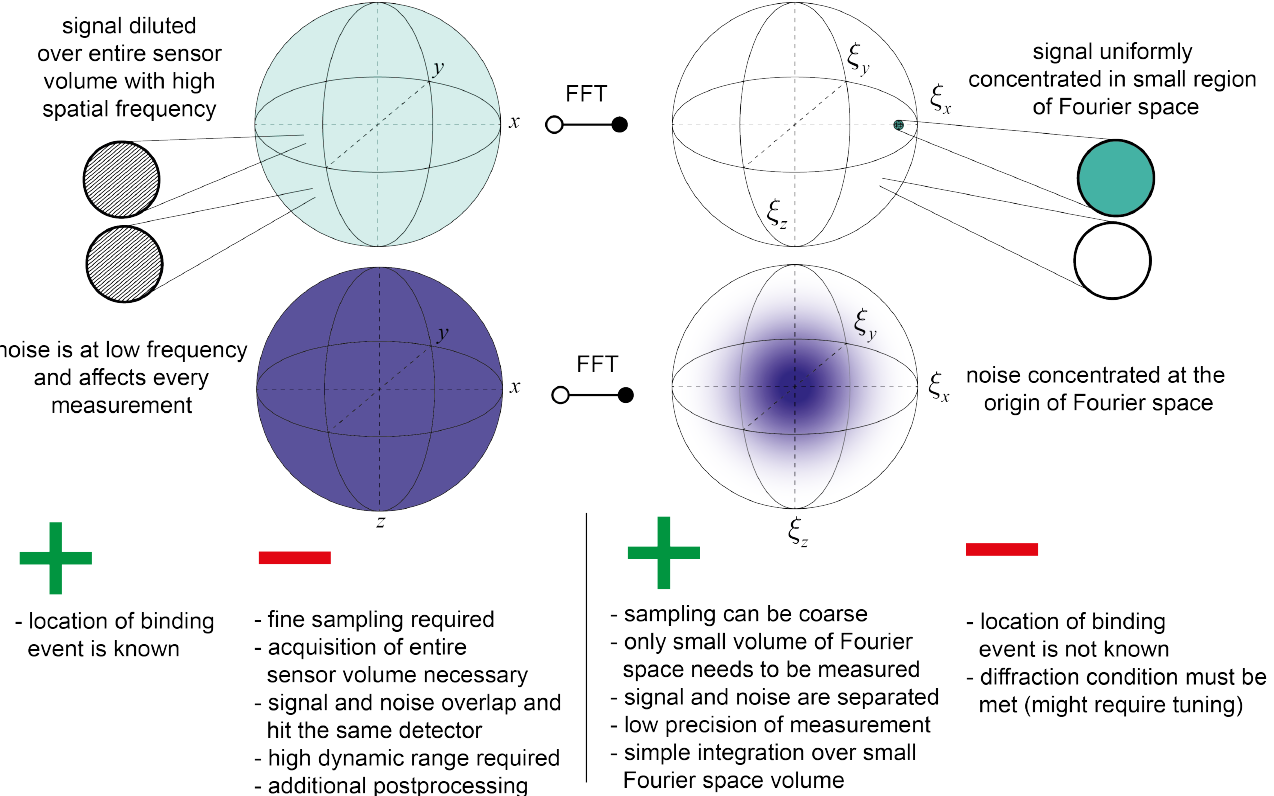
Figure 4. Advantages and disadvantages of digital and analog spatial lock-in amplifiers. Digital lock-in amplifiers such as surface plasmon resonance sensors using distributed referencing acquire the signal in real space whereas analog lock-in amplifiers (diffractometric sensor) sample directly reciprocal space. Due to this simple difference analog lock-in amplifiers have numerous advantages over digital